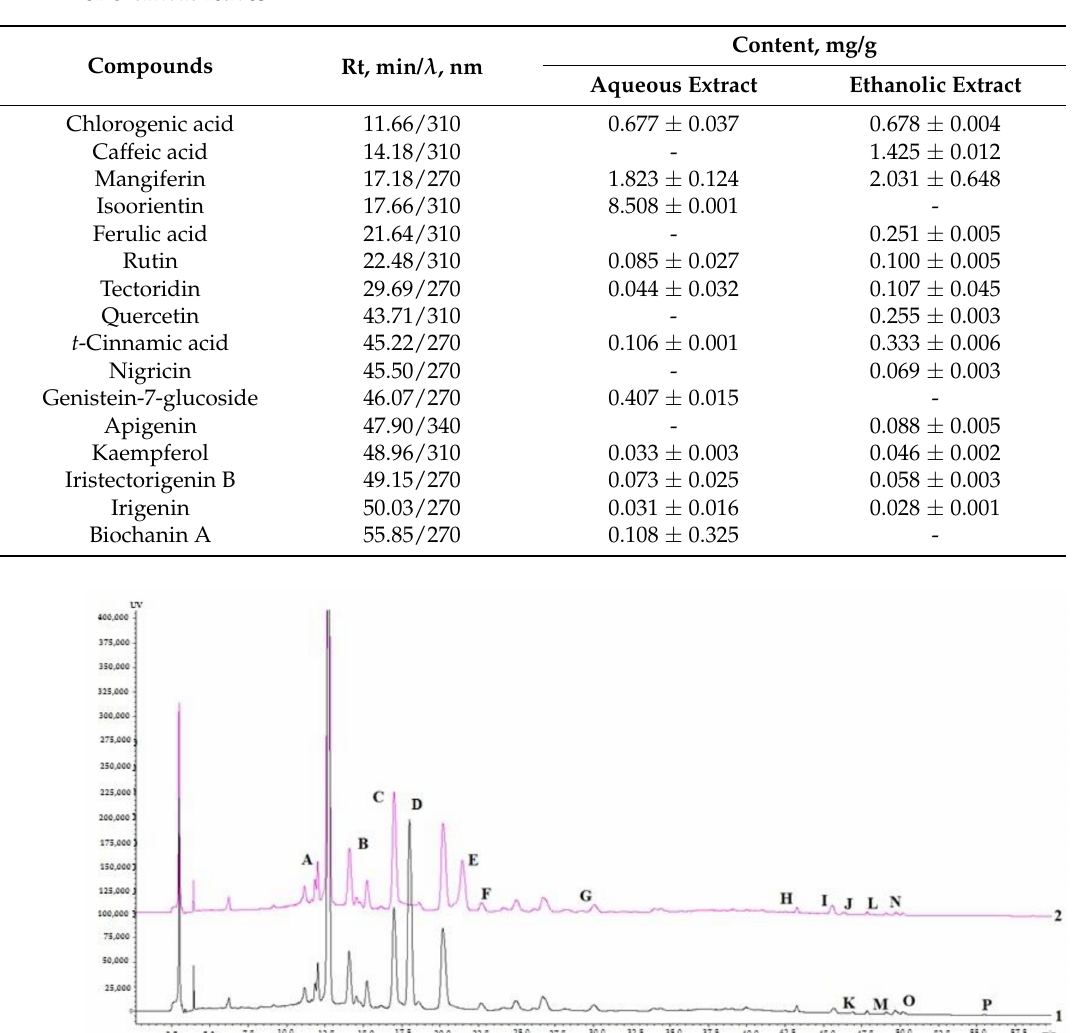
Table 1. Secondary metabolite contents (mg/g dry weight) of the aqueous and ethanolic dry extracts of C. sativus leaves.